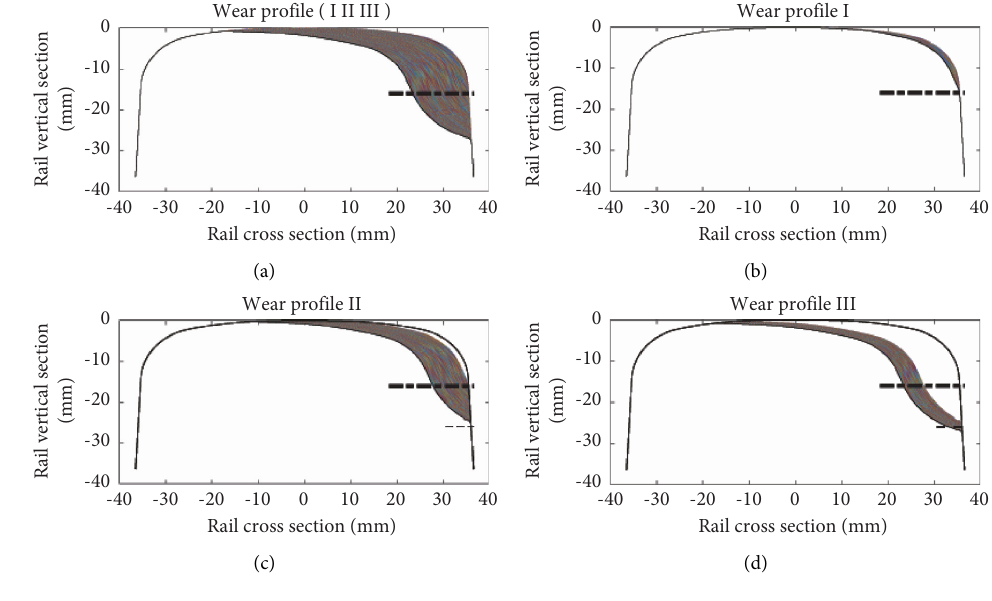
Figure 3: The wear profile evolution due to Table 1: Distribution range of influence parameters.